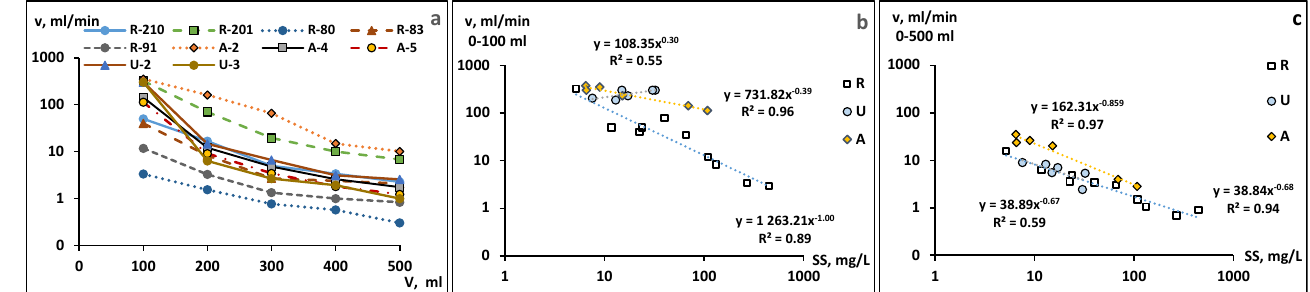
Figure 2. ( a ) Dynamic of the filtration rate (ml/min) decrease at the successive filtration of river water samples. ( b ) Dependence of the filtration rate on the first 100 mL of water with different concentrations of suspended solids SS (mg/L). ( c ) Dependence of the filtration rate on 500 mL water samples. R, U, A, Razdolnaya R., Ussuri R., and Amur R., respectively.